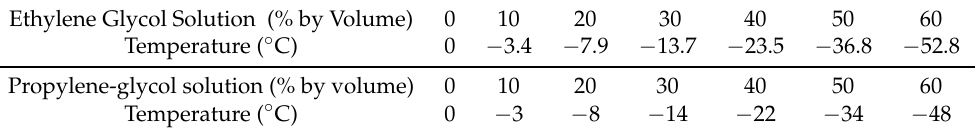
Table 1. Freezing points of ethylene-glycol- and propylene-glycol-based water solutions at various temperatures